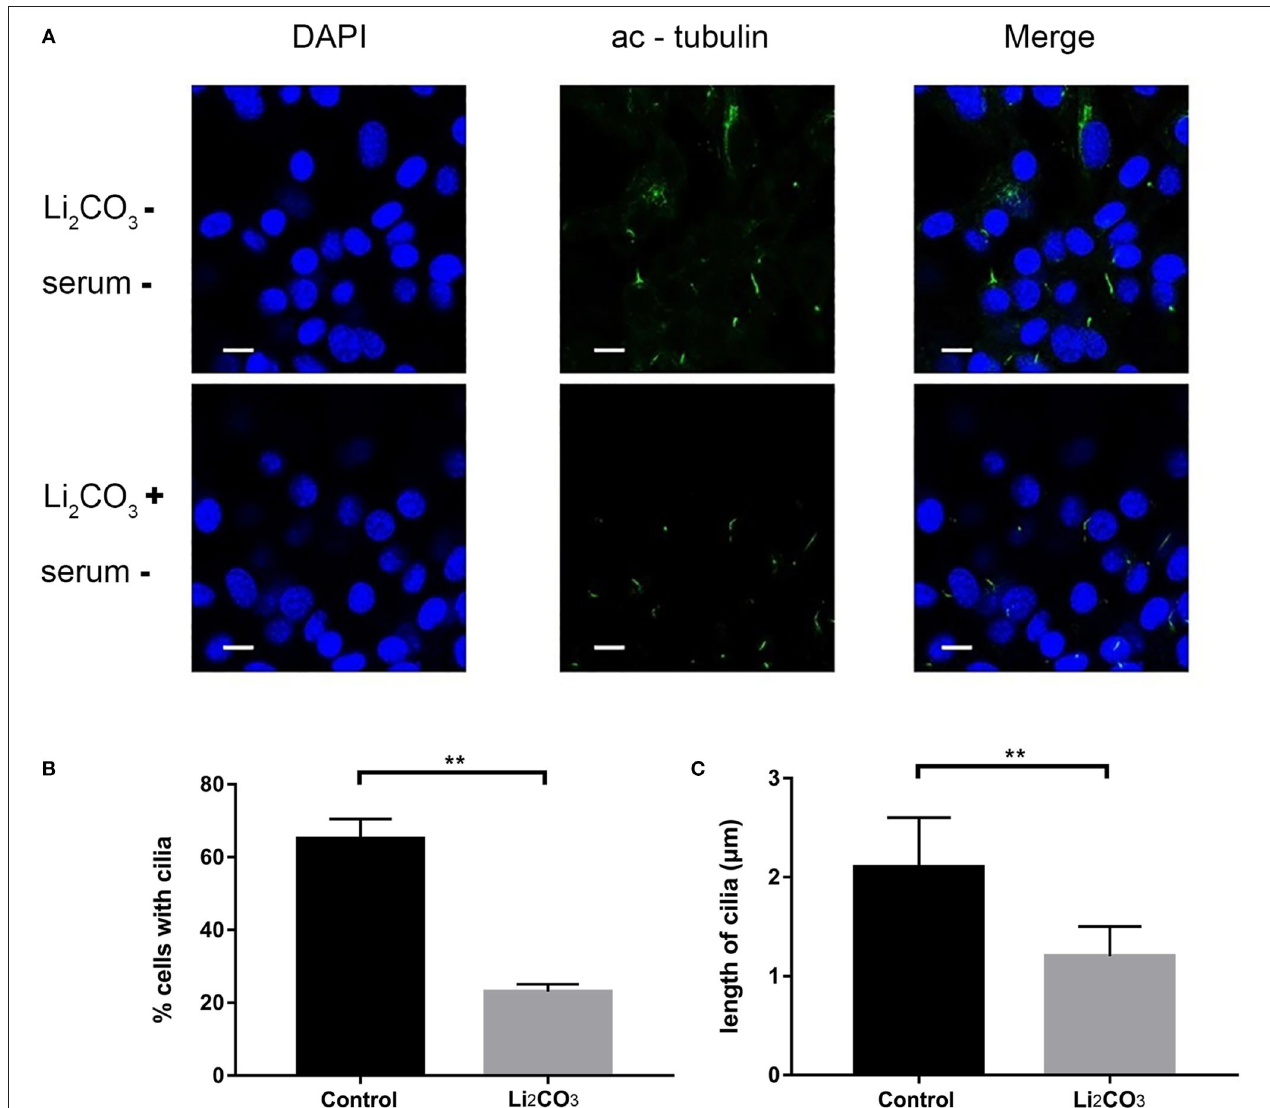
FIGURE 5 | Immunofluorescence of abnormal cilia in inositol deficiency cell model. (A) Immunofluorescence representative images of NIH3T3 cells treated with ( n = 3) or without 2mM Li 2 CO 3 ( n = 3), and stained for primary cilia (green, acetylated tubulin) and nucleus (blue, DAPI). Scale bars, 10 µ m. (B) Analysis of the percentage of cells with cilia. A total of > 100 cells were analyzed per replicate (four replicates). ** P < 0.01 vs. controls. (C) Quantification of cilia length in NIH3T3 cells. Error bars represent standard error. A total of > 100 cells were analyzed per replicate (four replicates). ** P < 0.01 vs. control group. Each experiment was carried out in